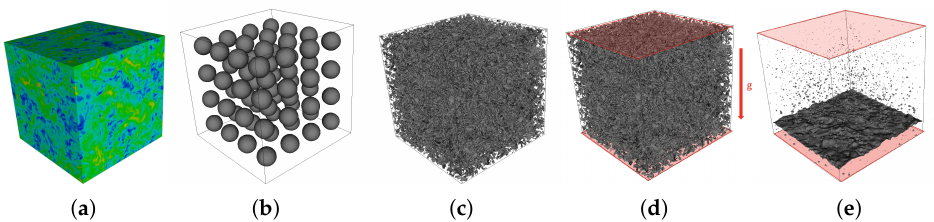
Figure 1. Simulation setup: ( a ) single-phase forcing, ( b ) initialization of the droplets of the disperse phase, ( c ) turbulent emulsion in the statistically steady state, ( d ) deactivation of the forcing, switching on of the gravitational acceleration, and prescription of slip walls in the direction of the gravitational acceleration (red walls), ( e ) segregation of the emulsion caused by the gravitational acceleration, g